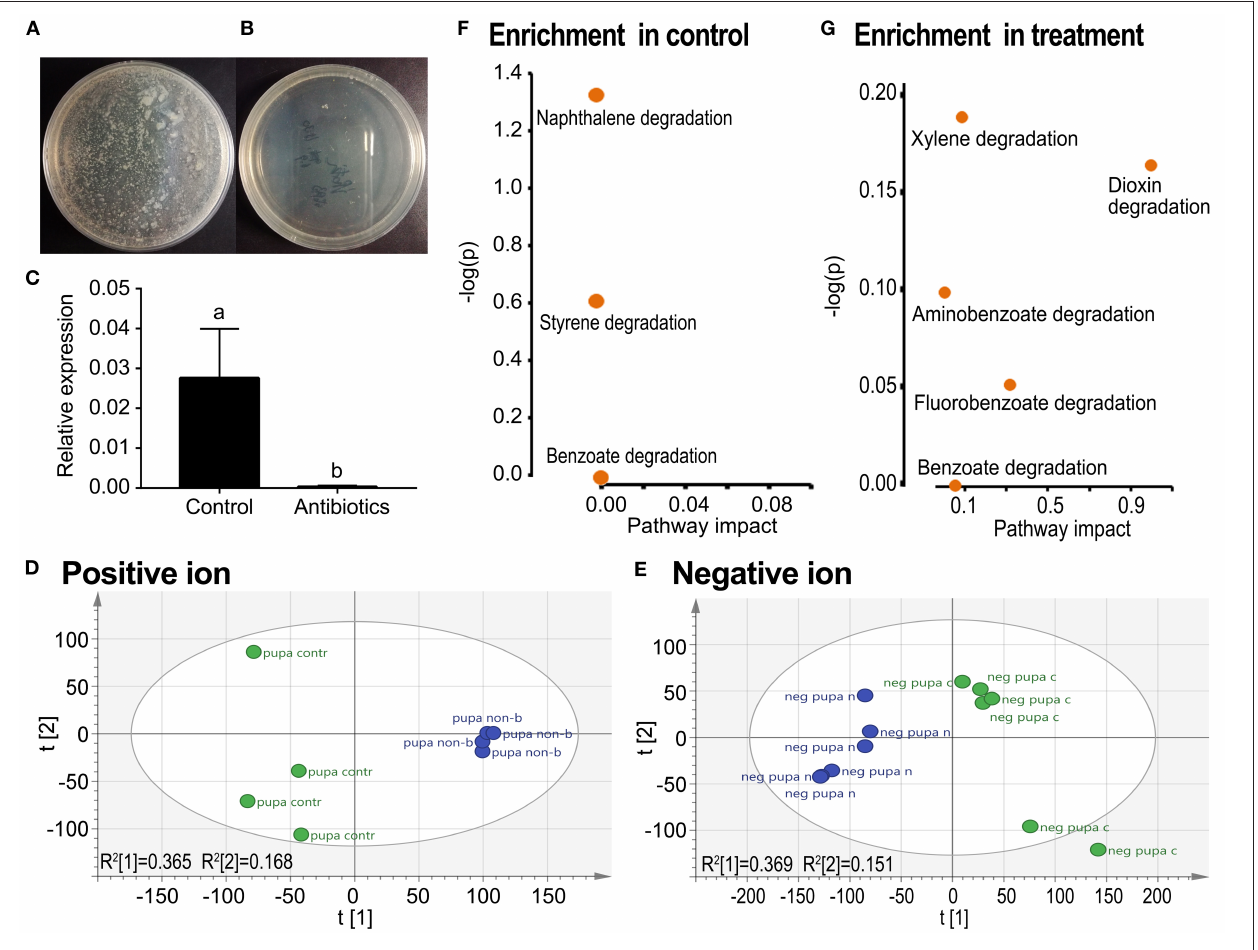
Frontiers in Physiology |